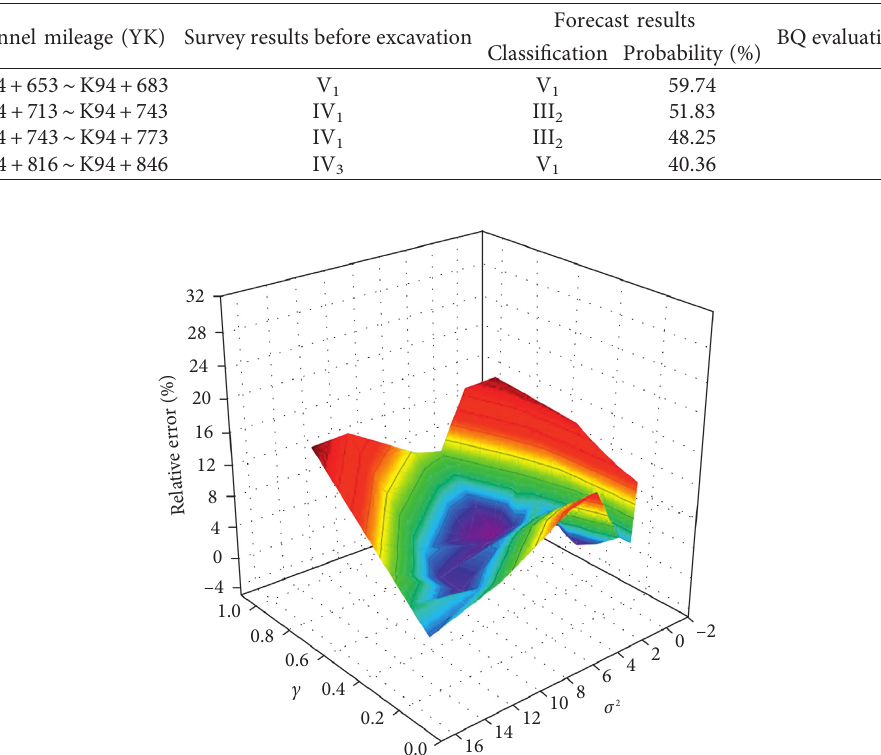
Figure 8: The influence law of LSSVM parameters on regression